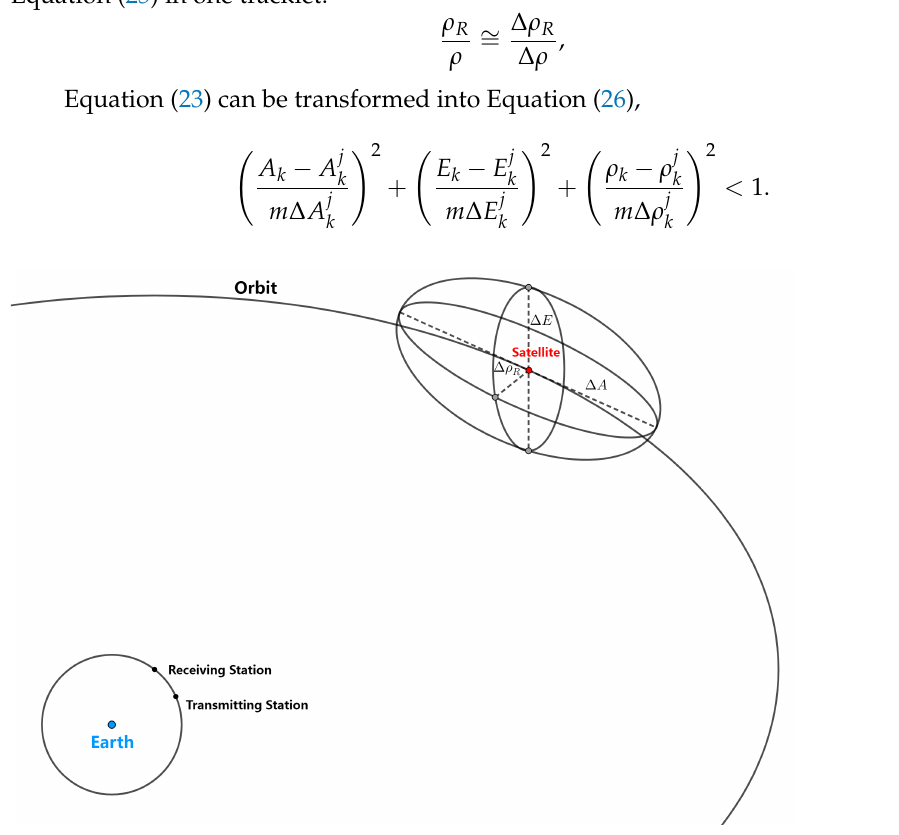
Figure 3. Error ellipsoid of observations of a receiving